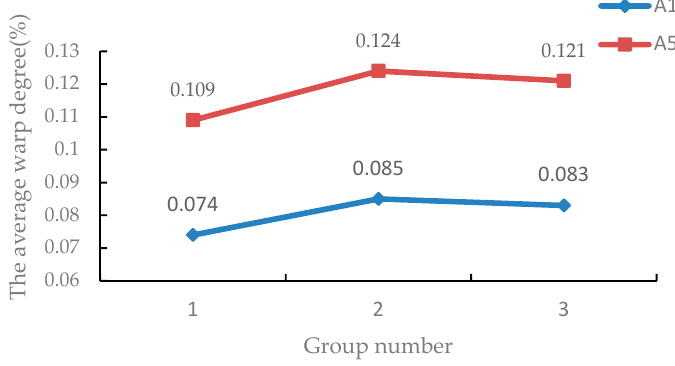
Figure 9. E ff ect of the glue spread on warp Figure 9. Effect of the glue spread on warp degree.